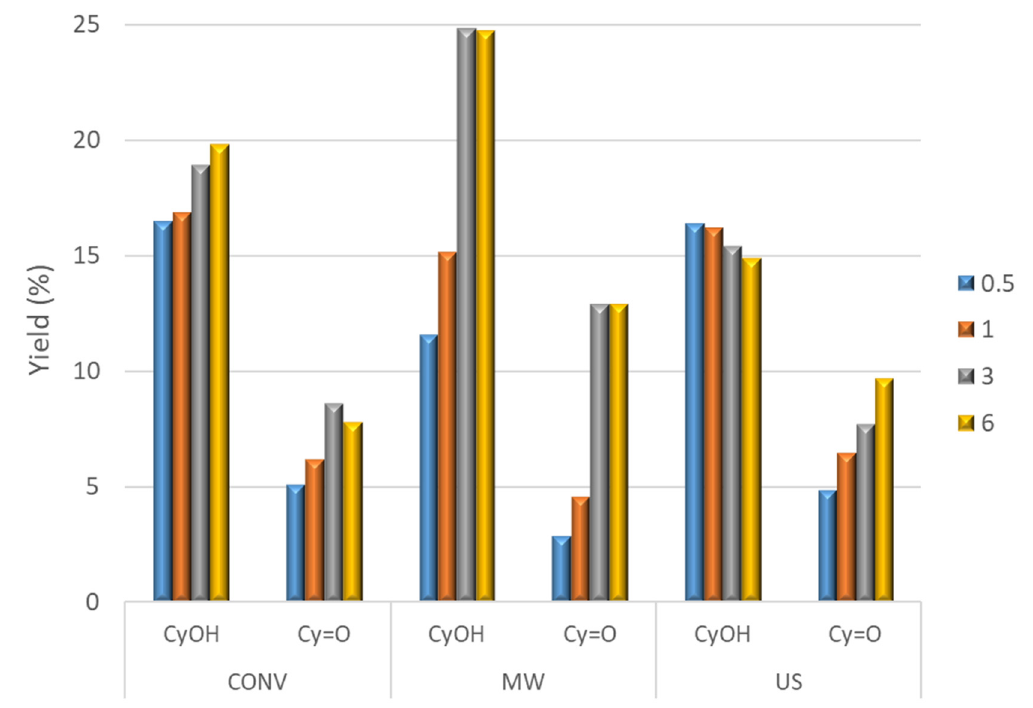
Figure 4. Effect of different energy stimuli on the oxidation of cyclohexane catalyzed by 1 . Reaction Figure 4. E ff ect of di ff erent energy stimuli on the oxidation of cyclohexane catalyzed by 1 . conditions: CyH (5 mmol); 1 (10 μ mol); TBHP (70% aqueous) (10 mmol); NCMe (3 mL); Reaction conditions: CyH (5 mmol); 1 (10 µ mol); TBHP (70% aqueous) (10 mmol); NCMe (3 mL); n(HNO 3 )/n ʹ (catalyst) = 25; 50 °C; 0.5-6 h. CONV = under conventional heating with oil bath; MW = n(HNO 3 ) / n (cid:48) (catalyst) = 25; 50 ◦ C; 0.5-6 h. CONV = under conventional heating with oil